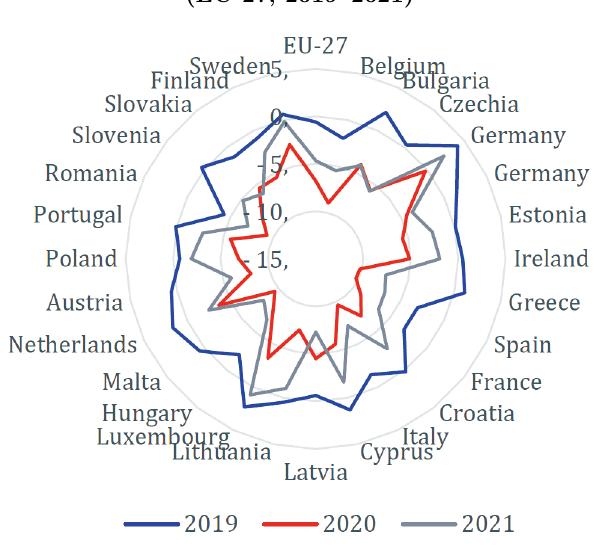
General government net lending(+)/net borrowing as a percentage of GDP (EU-27;